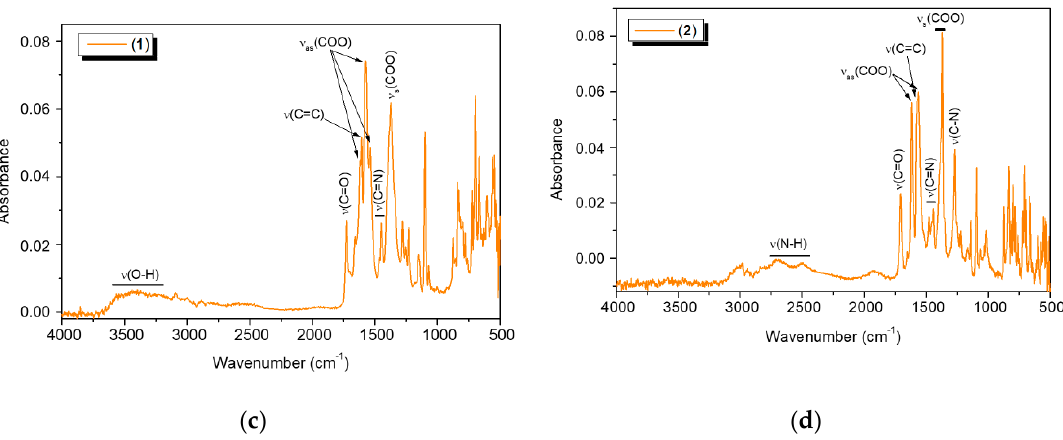
Figure 7. ( a ) The non-zwitterionic and zwitterionic form of 2,3pydcH 2 ; the FT-IR spectra of: ( b ) 2,3pydcH 2 , ( c ) complex 1 and ( d ) complex 2 .